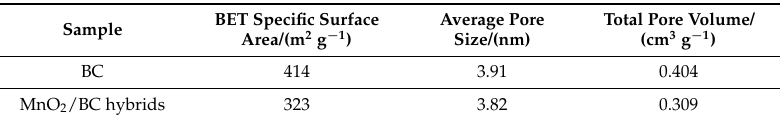
Table 1. Relevant parameters for the pore properties determined by nitrogen adsorption and desorption isotherms of the BC and MnO 2 /BC